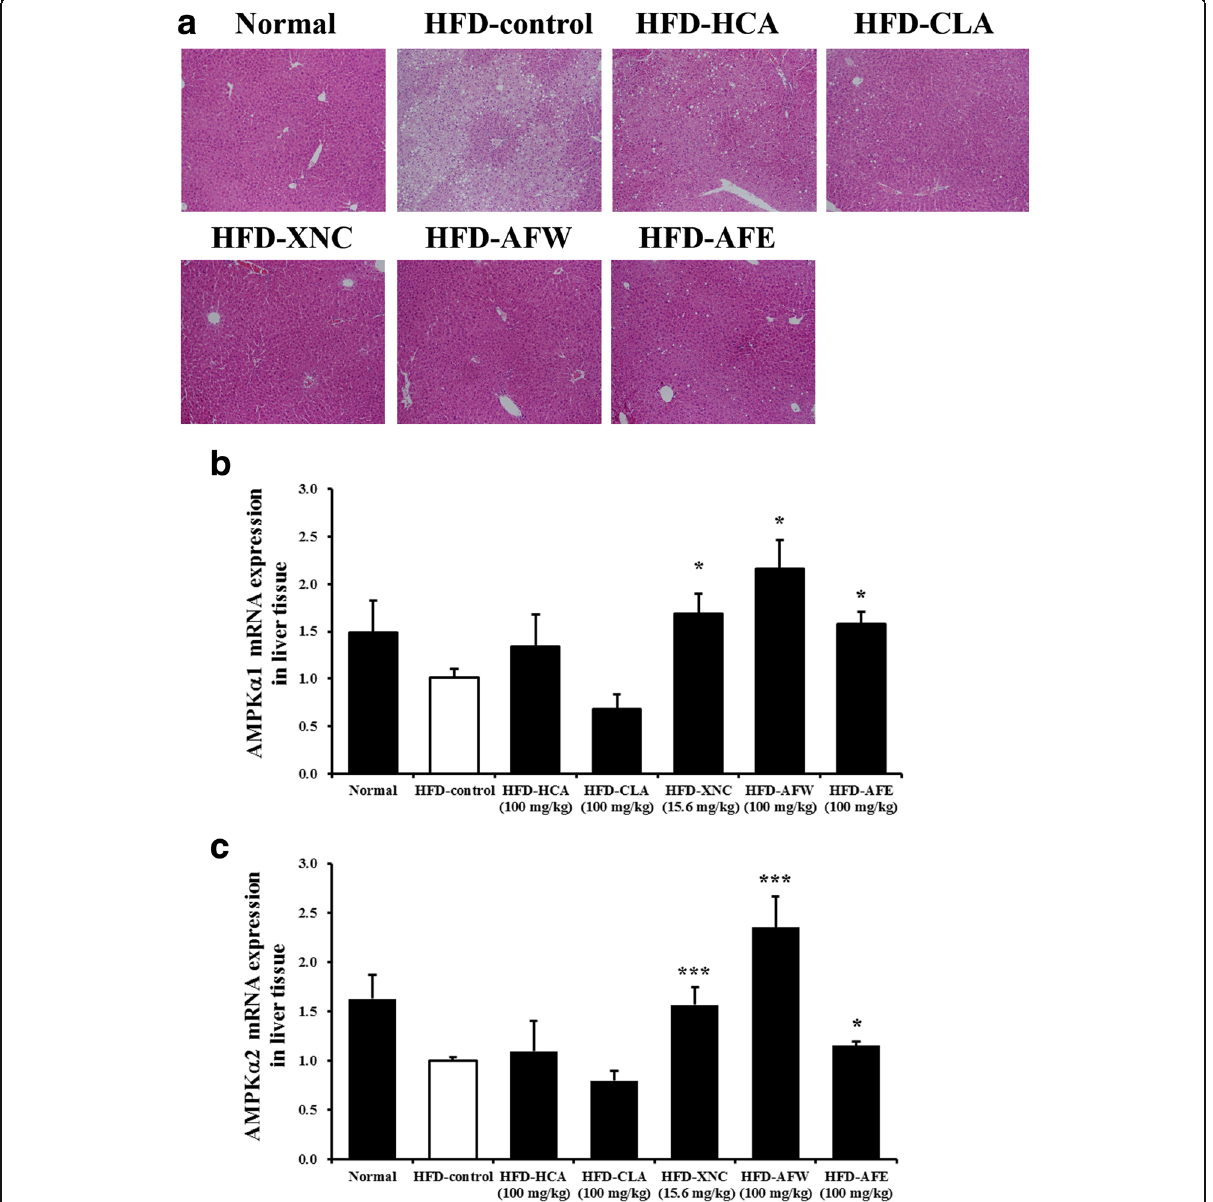
Fig. 5 Effect of 6-week treatment with Allium fistulosum aqueous extract (AFW) and A. fistulosum ethanolic extract (AFE) on histology and gene expression in the liver tissue of high-fat diet (HFD)-induced obese mice. a Representative photographs of hematoxylin and eosin-stained liver sections (magnification, 400×). b Expression of adenosine monophosphate-activated protein kinase (AMPK) isoforms AMPK α 1 and AMPK α 2 mRNA in the liver, as assessed by real- time reverse-transcription polymerase chain reaction (RT-PCR). Normal, standard chow; HFD-control, HFD only; HFD-HCA, HFD plus 100 mg/kg Garcinia cambogia extract containing hydroxycitric acid; HFD-CLA, HFD plus 100 mg/kg conjugated linoleic acid; HFD-ORL, HFD plus 15.6 mg/kg Xenical (orlistat); HFD-AFW, HFD plus 100 mg/kg AFW; HFD-AFE, HFD plus 100 mg/kg AFE. Results are expressed as the mean±standard error of the mean (SEM) ( n =6). * p <0.05, *** p <0.001 compared with the HFD-control